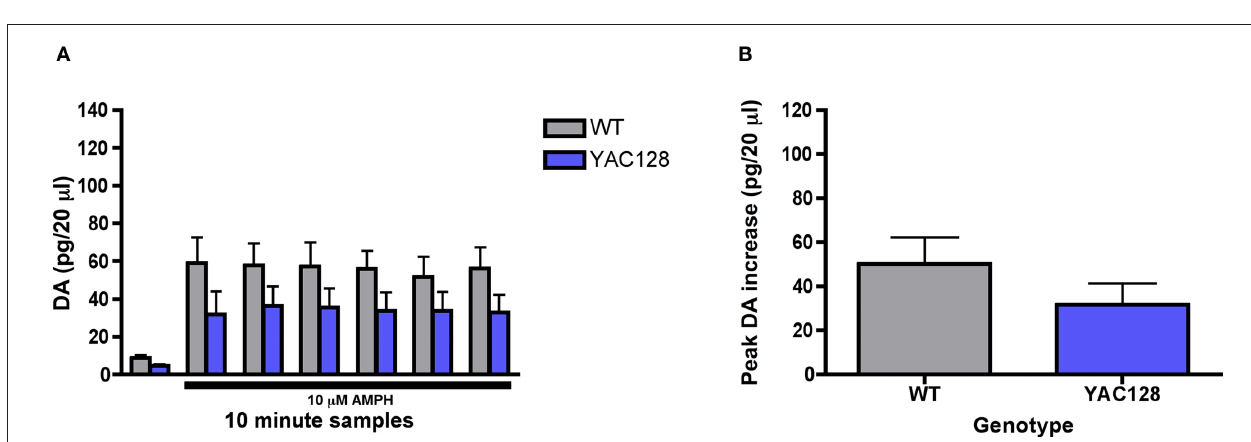
Figure 7 | effect of intrastriatal application of amphetamine (10 μM) on striatal (A) dopamine release and the (B) maximum peak increase in dopamine efflux in 7-month-old YAC128 transgenic mice ( n = 5 WT, 9 YAC128). Presence of amphetamine in perfusate is indicated by black bar. Data are picograms per 20 μl sample. All data are mean ± SEM. * Indicates significantly different from WT, P < 0.05; ** indicates P < 0.001; *** indicates P